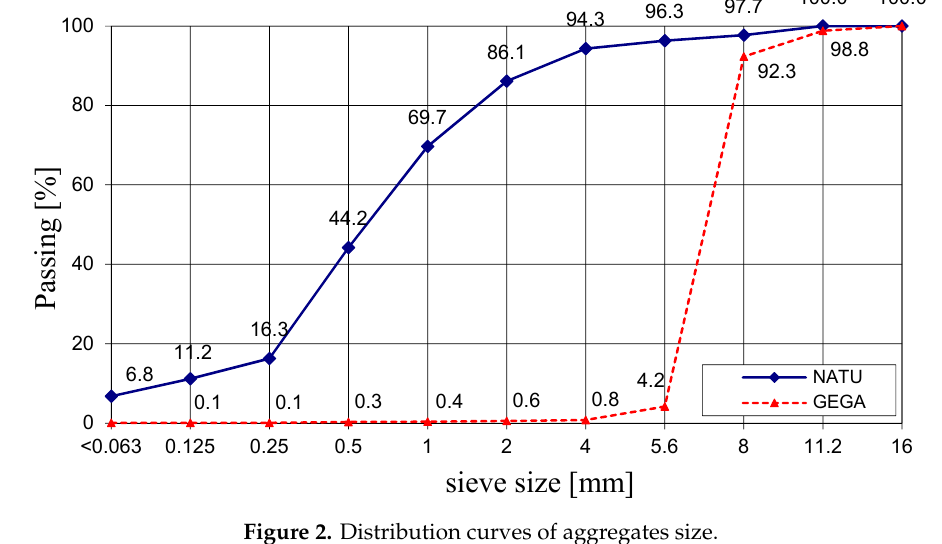
Figure 2. Distribution curves of aggregates size. Table 2. Chemical composition of the